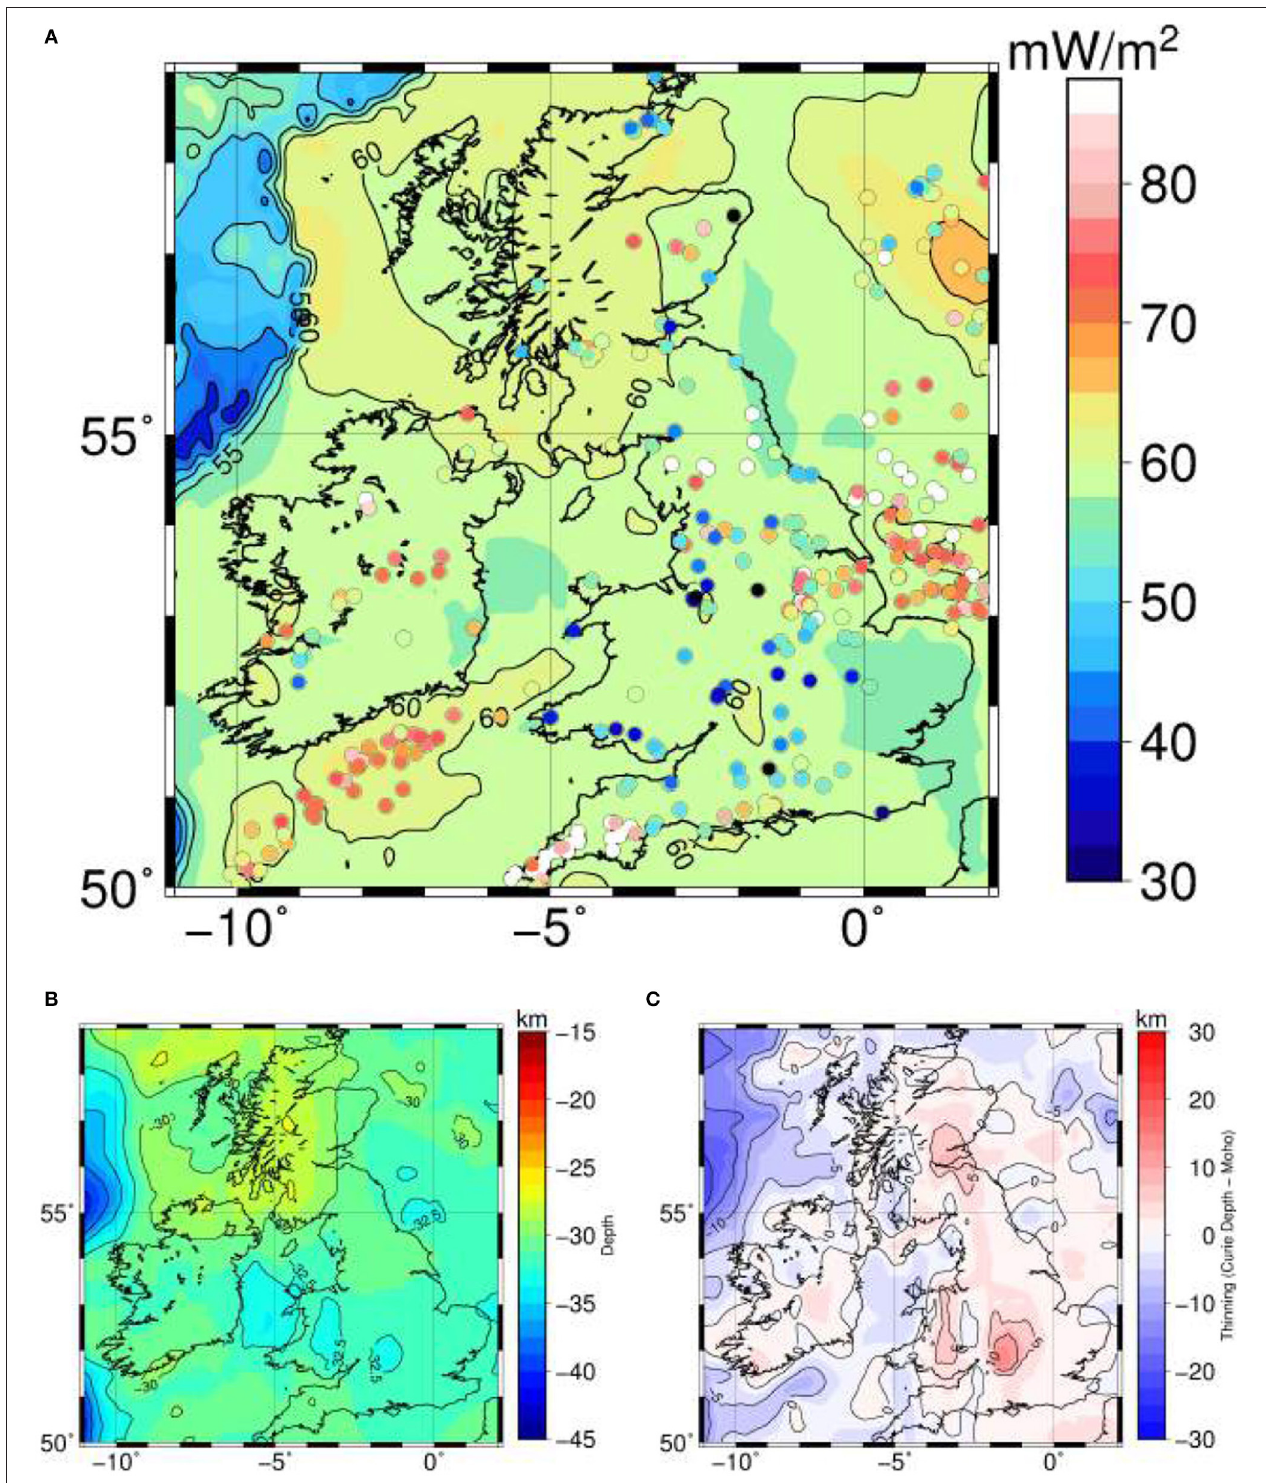
FIGURE 9 | Thermal modeling results for model M1_s (see text for further details). (A) Synthetic surface heat flow. Dots show available measured heat flow data from the International Heat Flow Commission. (B) Synthetic Curie temperature depth. (C) Difference between Curie temperature and Moho depth. Red color represents areas where the Curie isotherm is above the Moho and vice